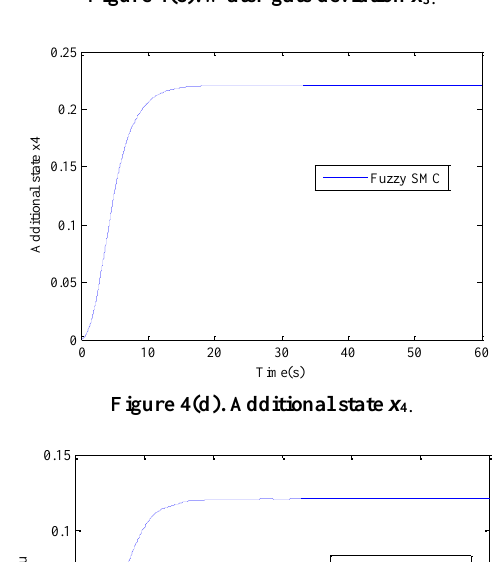
Figure 4(c). Water gate deviation x 3.